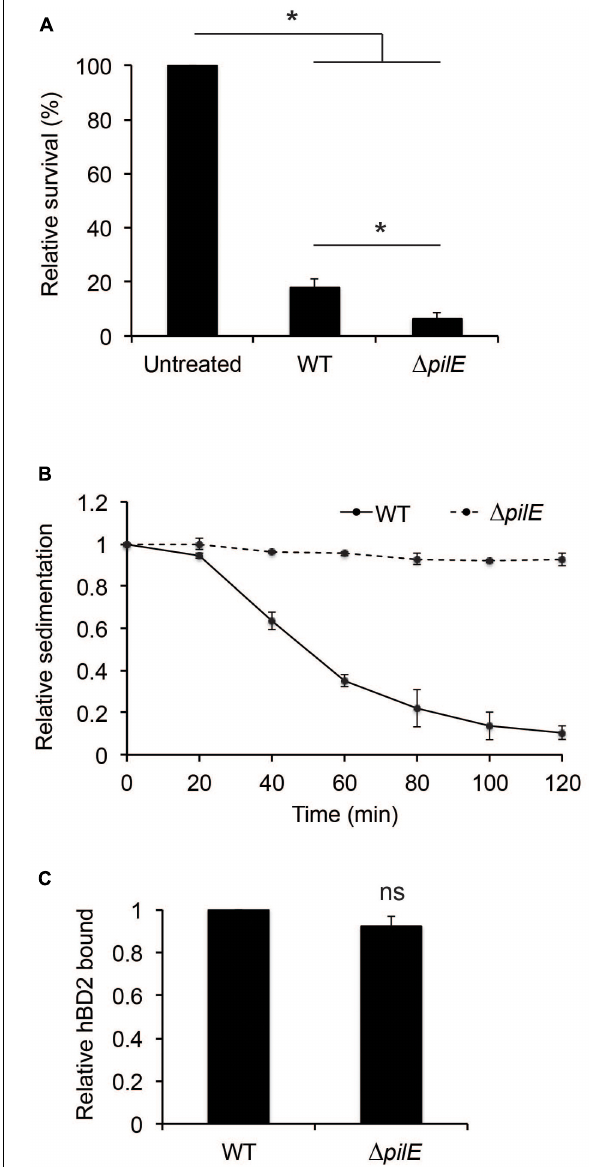
FIGURE 4 | Human beta-defensin 2-binding and aggregation of wild-type and (cid:49) pilE bacteria. (A) Survival of log-phase bacteria of wild-type (WT) and (cid:49) pilE incubated with 1 µ M hBD2 for 3 h. Viable counts were determined by plating. Values are expressed as the mean survival relative to the untreated control. The assay was performed in triplicate at least three times. (B) Aggregation of bacteria determined by a sedimentation assay. WT and the (cid:49) pilE mutant were grown to log phase, pelleted, resuspended in modified DMEM assay medium, and incubated under static conditions at room temperature. Optical density measurements of the top layer were made at 20 min intervals. Values are expressed relative to the 0 min timepoint. The assay was performed in single samples at least three times. (C) WT and (cid:49) pilE were grown to log phase and then incubated with 1 µ M hBD2 for 3 h. Bacteria were washed with PBS once, and bound hBD2 was determined by ELISA. Values are expressed relative to WT. Data are represented as the mean values, with error bars representing the standard deviation. The assay was performed in triplicate at least three times. Significance was tested against the untreated control, or against WT, as indicated. * P < 0.05; ns,